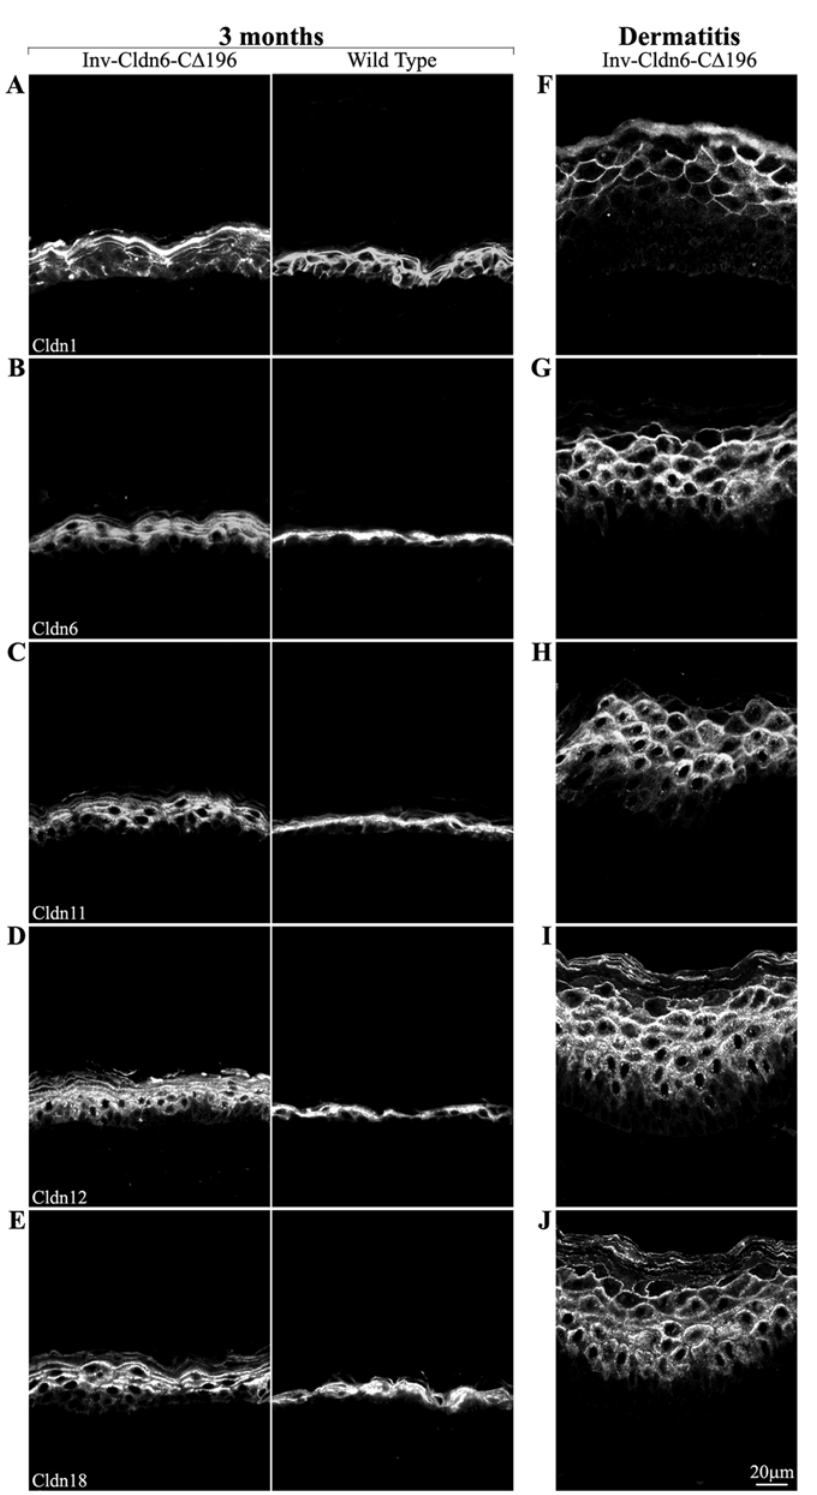
Figure 6. Evaluation of Cldns in the aging Inv-Cldn6-C D 196 transgenic epidermis. The expression/localization of Cldns was also perturbed in the aging Inv-Cldn6-C D 196 transgenic epidermis (samples are from 3-month-old mice – left panel); the dermatitis-affected zones are also shown (right panel). Cldn1-positive basal and suprabasal cells were reduced in the aging Inv-Cldn6-C D 196 epidermis ( A ). In addition, a shift away from a strictly membrane localization and an expanded zone of suprabasal Cldns was evident - Cldn6 ( B ), Cldn11 ( C ), Cldn12 ( D ) and Cldn18 ( E ). These abnormalities in were strikingly exacerbated in the dermatitis-affected epidermis. For instance, the basal and lower suprabasal layers were void of Cldn1 localization ( F ). In addition, Cldn6 ( G ), Cldn11 ( H ), Cldn12 ( I ) and Cldn18 ( J ) localization was observed throughout the expanded suprabasal zone with membranous localization less evident in the lower suprabasal layers.